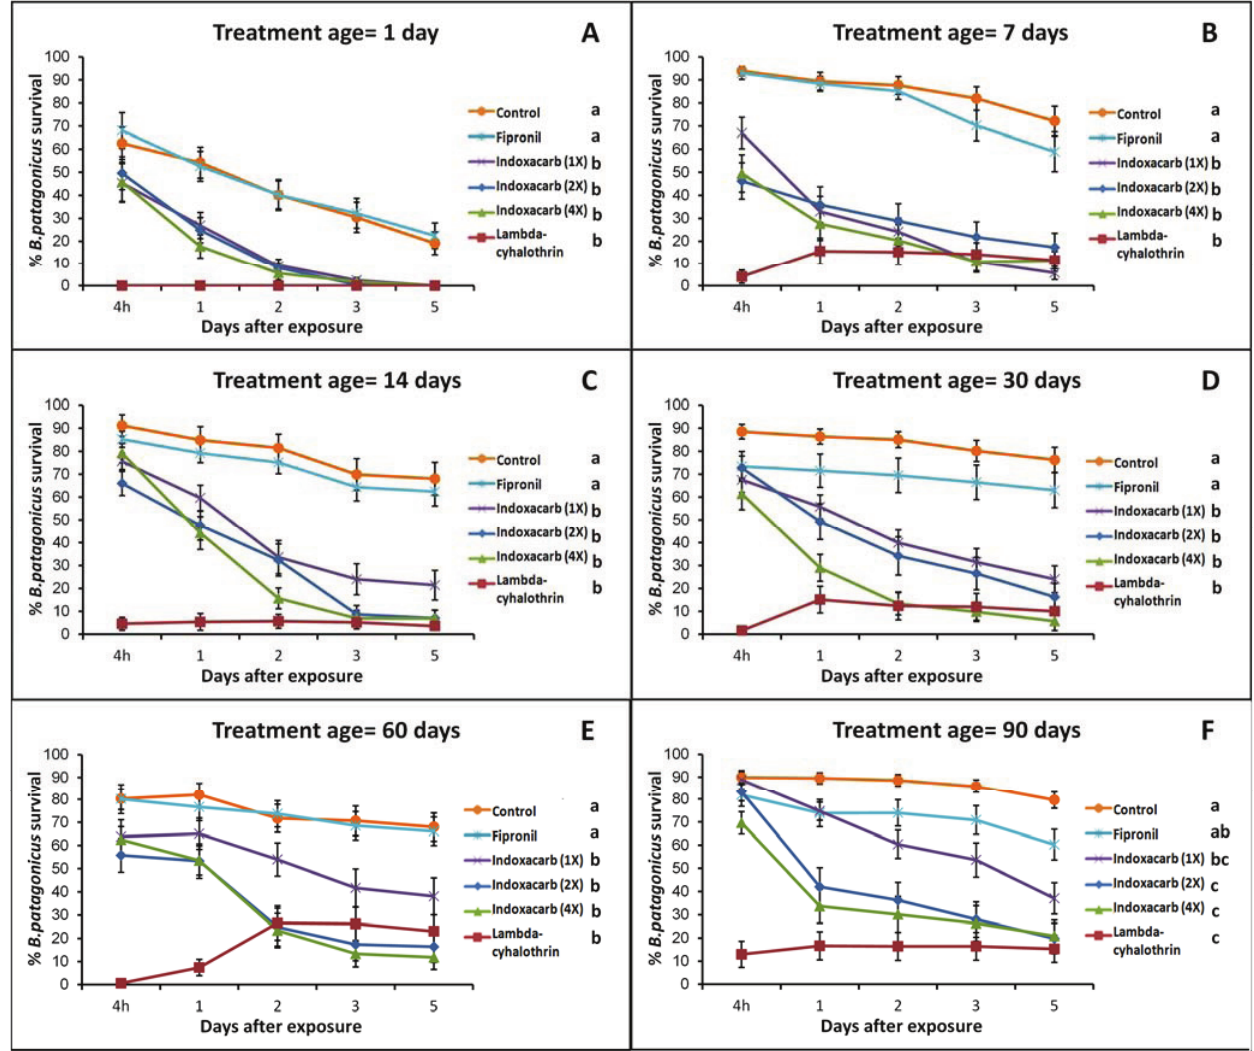
Figure 2. Mean percent ant survival under different insecticide treatments and using surfaces aged for different periods after application. Error bars were constructed with the standard error of the mean. Letters next to treatment names show the result of a post-hoc Tukey’s HSD test performed after one-way ANOVAs comparing the ant survival at 5 days after exposure. For the 1 day treatment age, a two sample t -test was used to compare the fipronil and control treatments instead since the survival at 5 days after exposure in the other treatments was zero for all